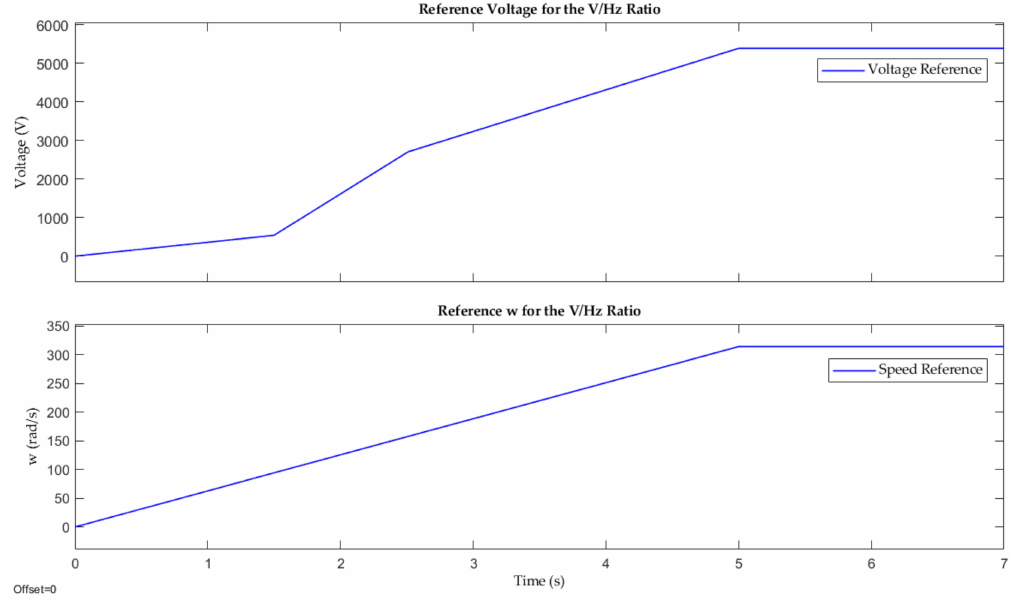
Figure 9. Customized voltage and w for AHSRA (proposed V/Hz